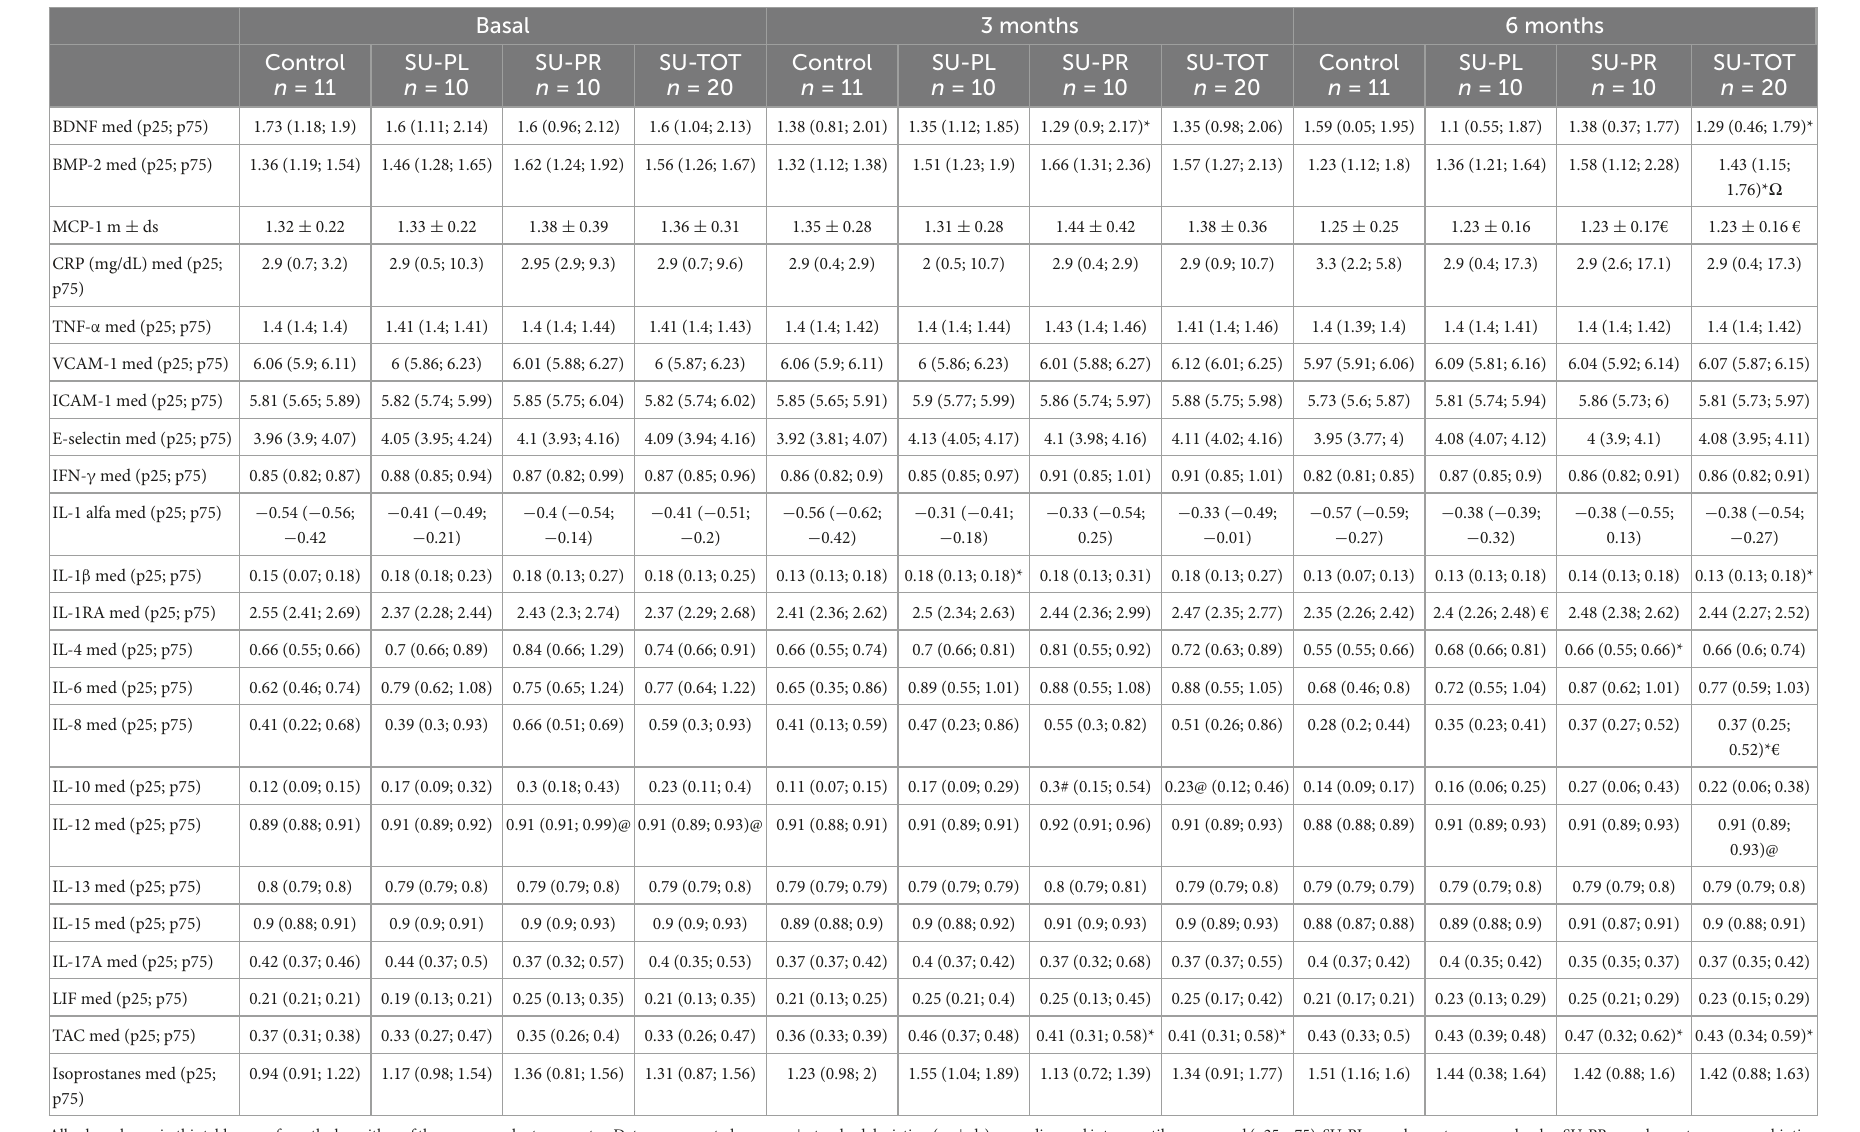
TABLE 6 Inflammation and oxidation